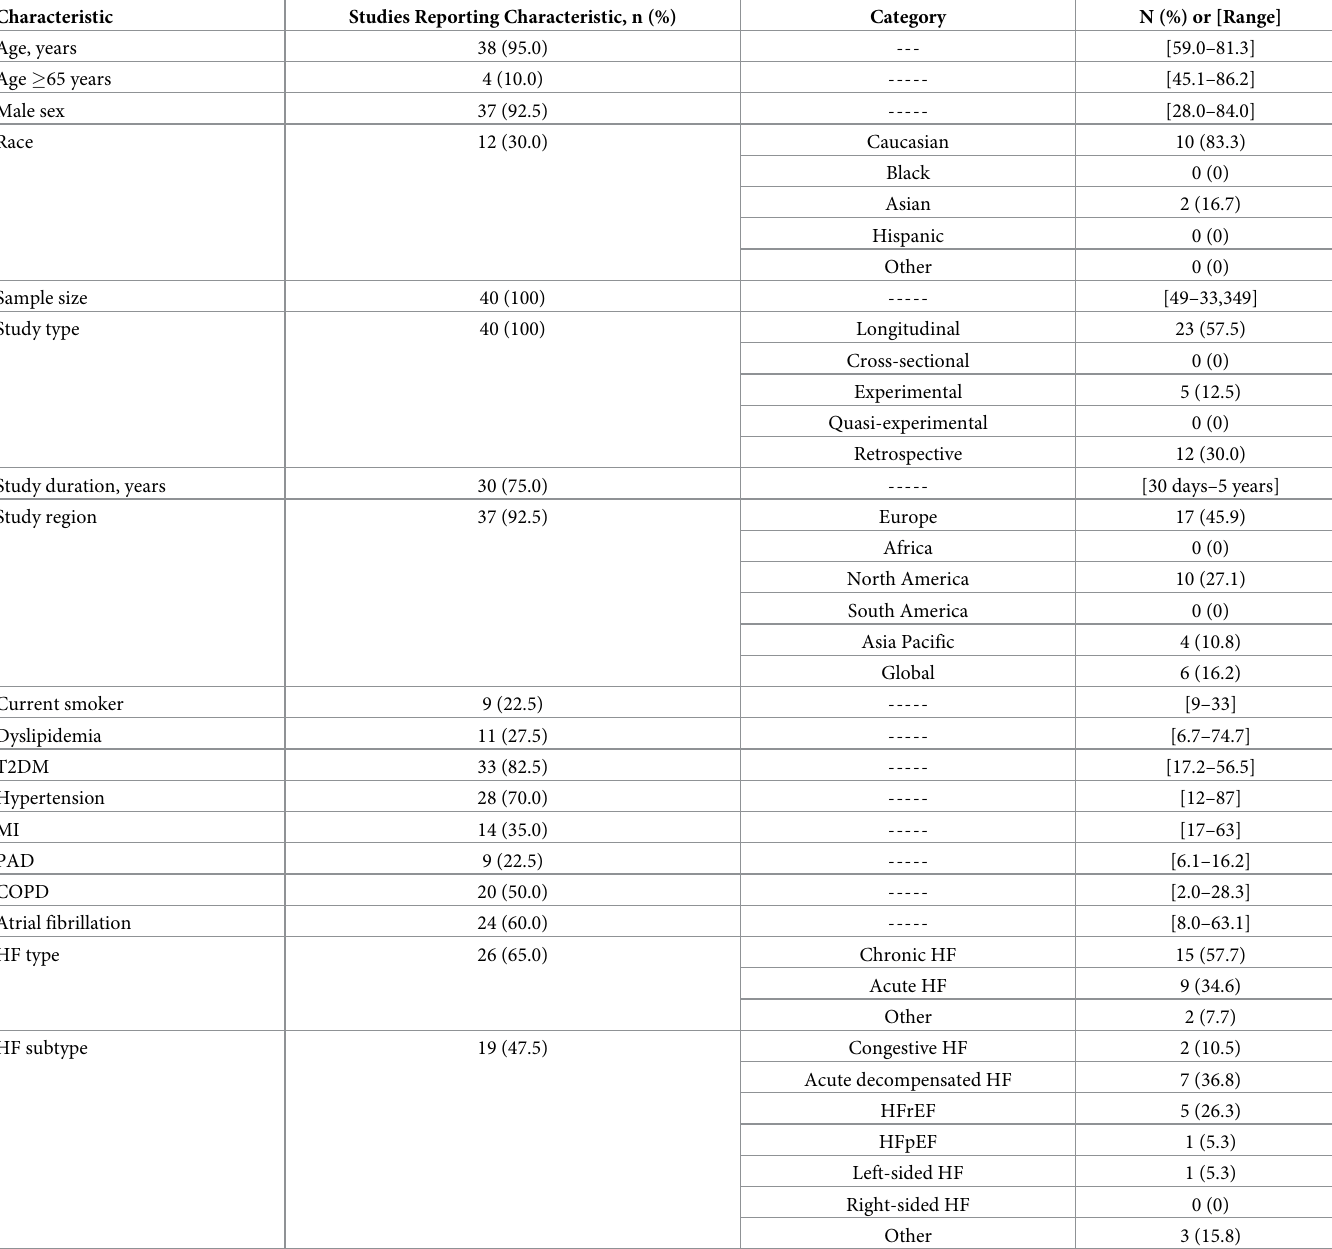
Table 1. Characteristics of the patient populations included in the 40 retrieved publications on models of HF risk prediction. Characteristic Studies Reporting Characteristic, n